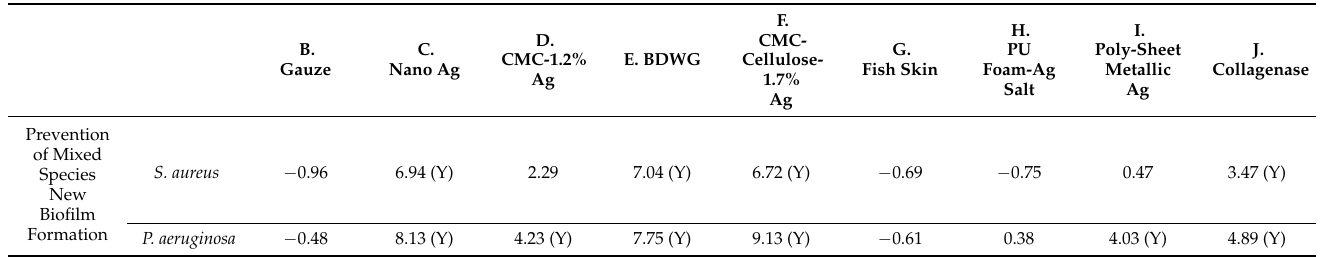
Table 1. Compiled Log CFU reduction of S. aureus and P aeruginosa species in comparison with untreated controls in a mixed-species CDFR biofilm prevention